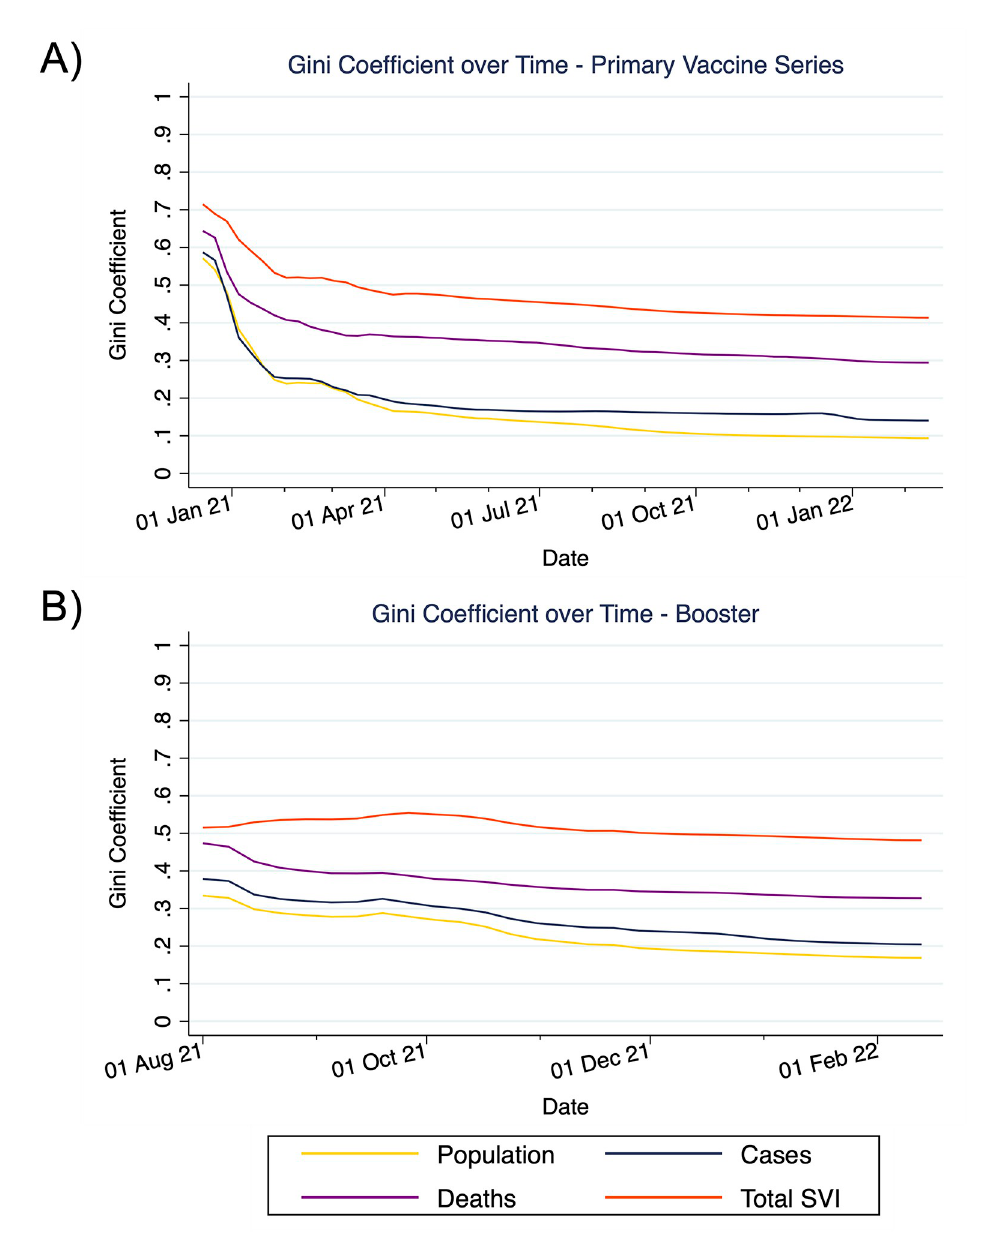
Fig 4. Temporal patterns in COVID-19 vaccine inequities AU : ThereisatypoinFig 4 B : 01 Dec 22 shouldbe 01 Dec 21 : Pleasefix : ð Whileyouareinthere ; Irecommendpresentingallyearsinthex (cid:0) axislabelsofbothfigurepartsconsistently : either 2 digitsor 4 ; ratherthanamixofbothformats : Þ . This figure depicts patterns in the Gini coefficients over time for inequities in receiving the primary vaccine series (A) and a booster (B) relative to population, diagnosed COVID-19 cases, COVID-19 deaths, and population-level social vulnerability. Gini coefficients were calculated on a weekly basis from Lorenz curves generated up through that time interval. SVI, Social Vulnerability Index.